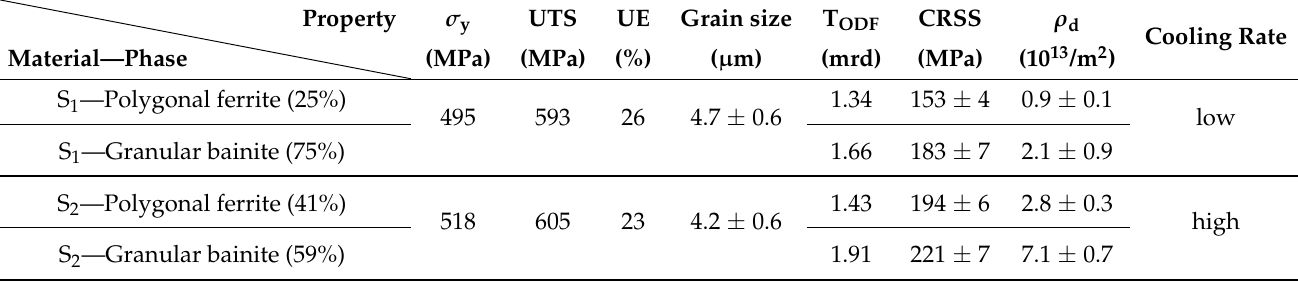
Figure 1. Experimental macroscopic tensile stress–strain curves in the rolling direction (RD) for the materials obtained from applying different cooling rates to a high-strength, low-alloy steel. Table 1. Summary of experimental results for materials S 1 and S 2 from